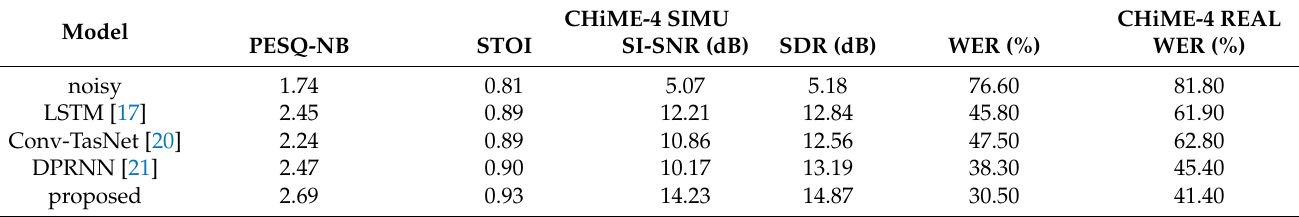
Table 7. Comparison with other methods on